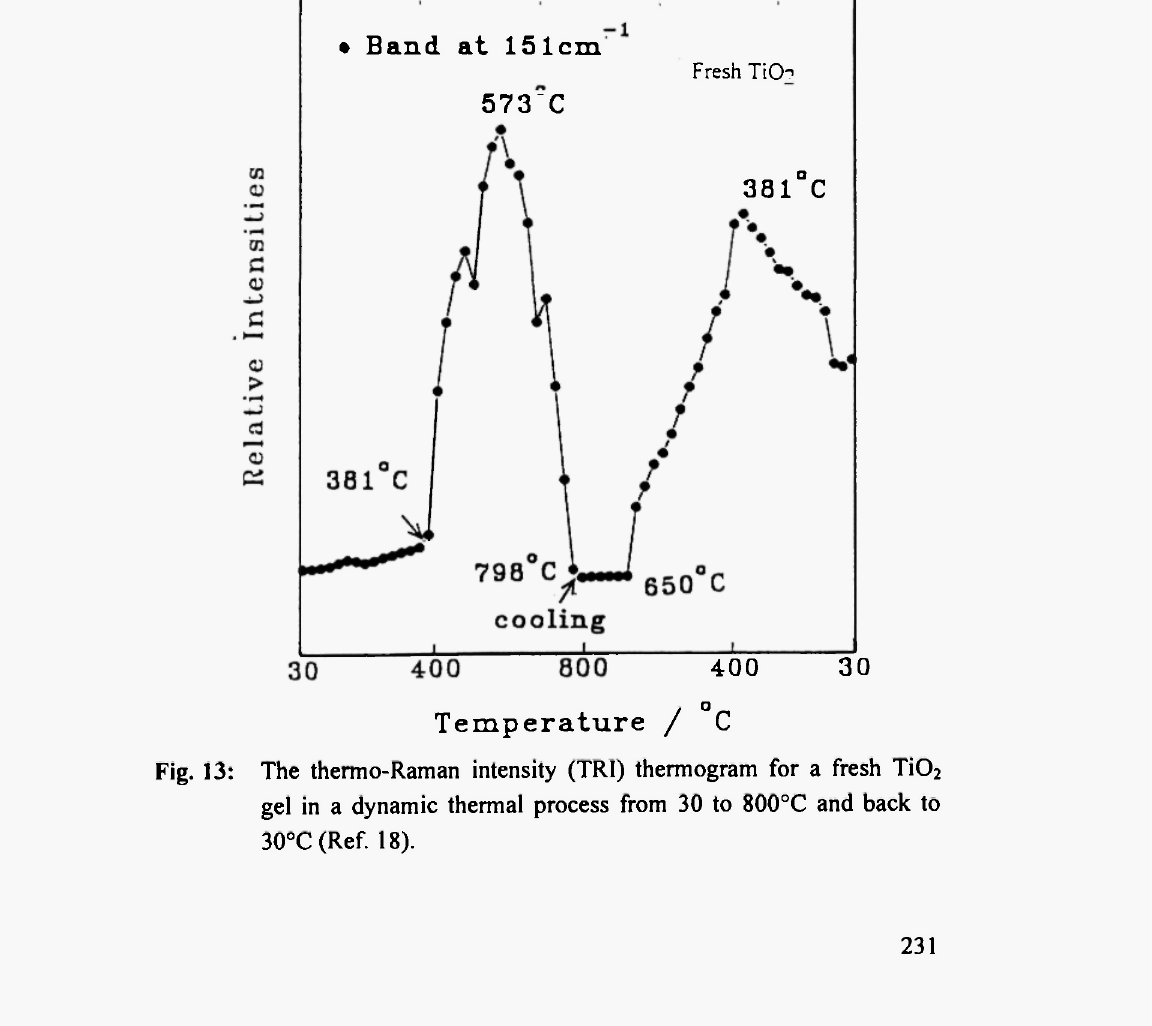
Fig. 13: The thermo-Raman intensity (TRI) thermogram for a fresh Ti0 2 gel in a dynamic thermal process from 30 to 800°C and back to 30°C (Ref.